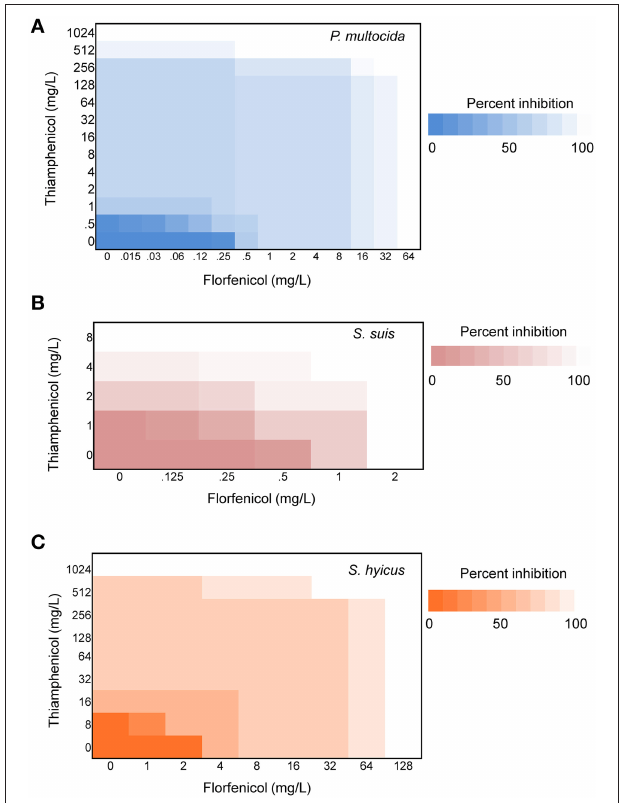
FIGURE 1 | Synergy of florfenicol and thiamphenicol. Checkerboard analyses showing the percentage inhibition on the combined effect of florfenicol and thiamphenicol against (A) P. multocida, (B) S. suis, and (C) S. hyicus. The magnitude of inhibition is shown as a heat plot.